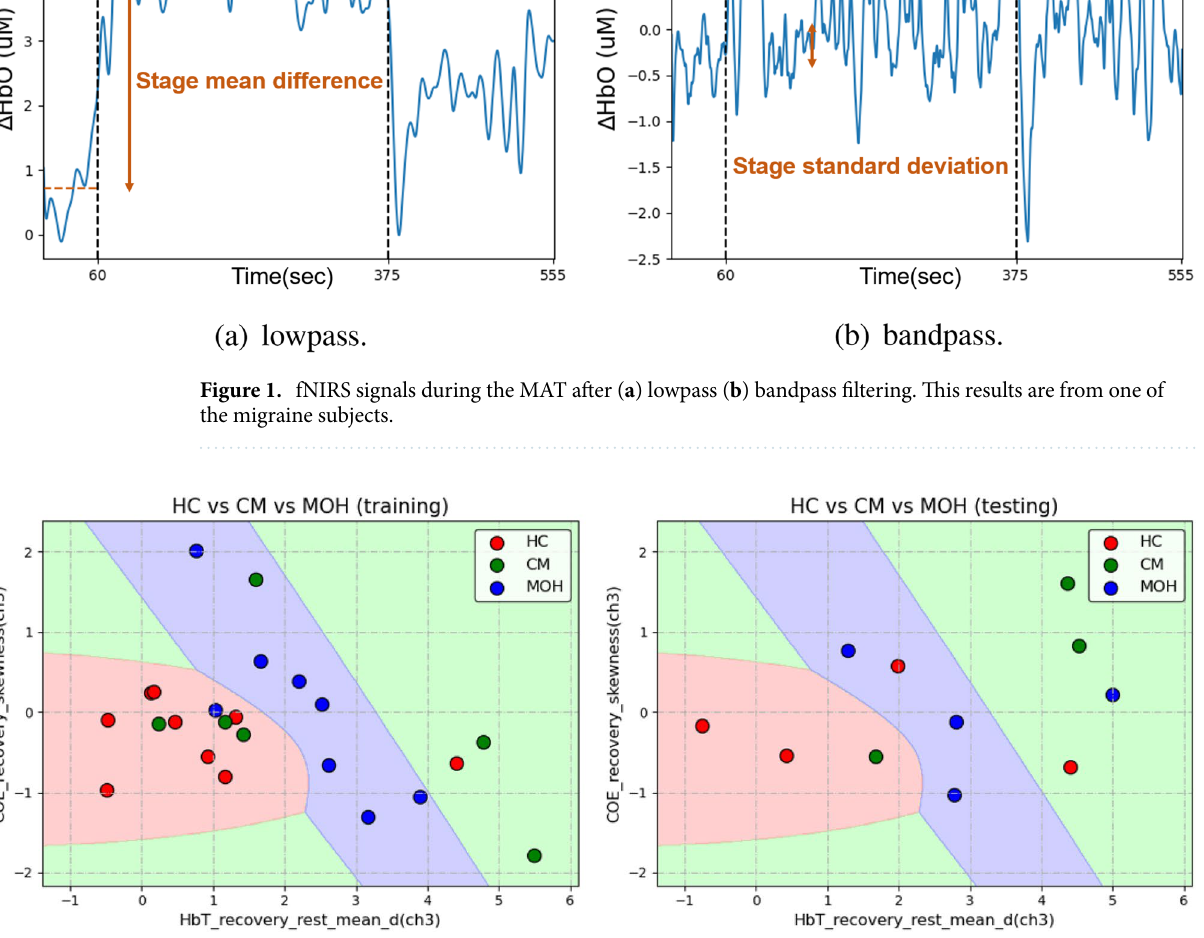
Figure 2. Result of direct